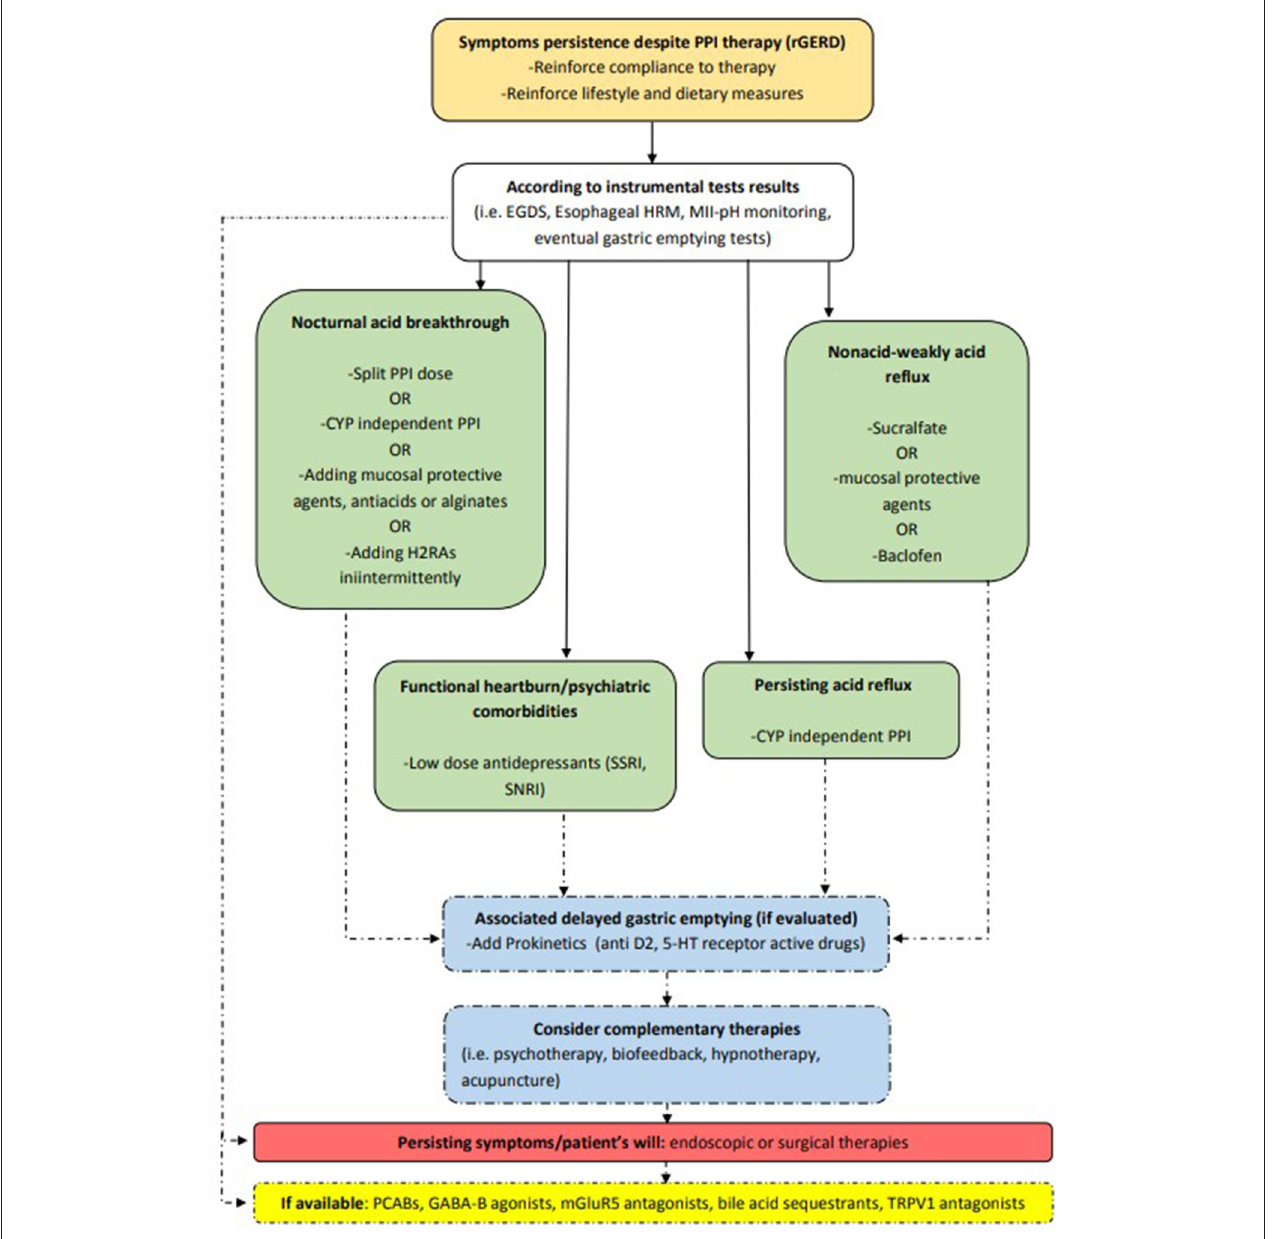
FIGURE 2 | Different therapeutic options in rGERD management according to pathophysiology. CYP, cytochrome P450; D2, dopamine 2; EGDS, esophagogastroduodenoscopy; EoE, eosinophilic esophagitis; GABA-B, gamma aminobutyric acid-B; H2RAs, histamine receptor 2 antagonists; HRM, high resolution manometry; mGluR5, metabotropic glutamate receptor-5; MII-pH, multichannel intraluminal impedance-pH; PCABs, potassium-competitive acid blockers; PPI, proton pump inhibitor; rGERD, refractory gastroesophageal reflux disease; SNRI, serotonin and norepinephrine reuptake inhibitor; SSRI, selective serotonin reuptake inhibitor; TRPV1, transient receptor potential vanilloid receptor-1; 5-HT,